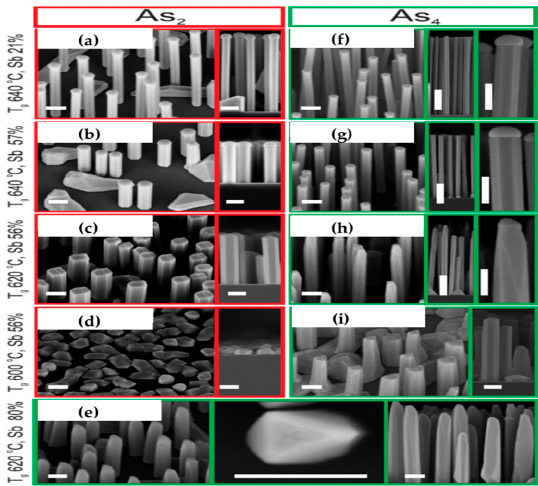
Figure 3. SEM images of GaAsSb NWs grown on Si (111) substrates. The scale bars are 200 nm, except in the lower magnification insets of sample h, they are 1 µm. Sb% refer to Sb flux%. The samples with red outlines ( a – d ) have been grown with As 2 while those with green outline ( e – i ) were grown with As 4 . Reproduced with permission from [63]; Copyright 2020, IOP publishing